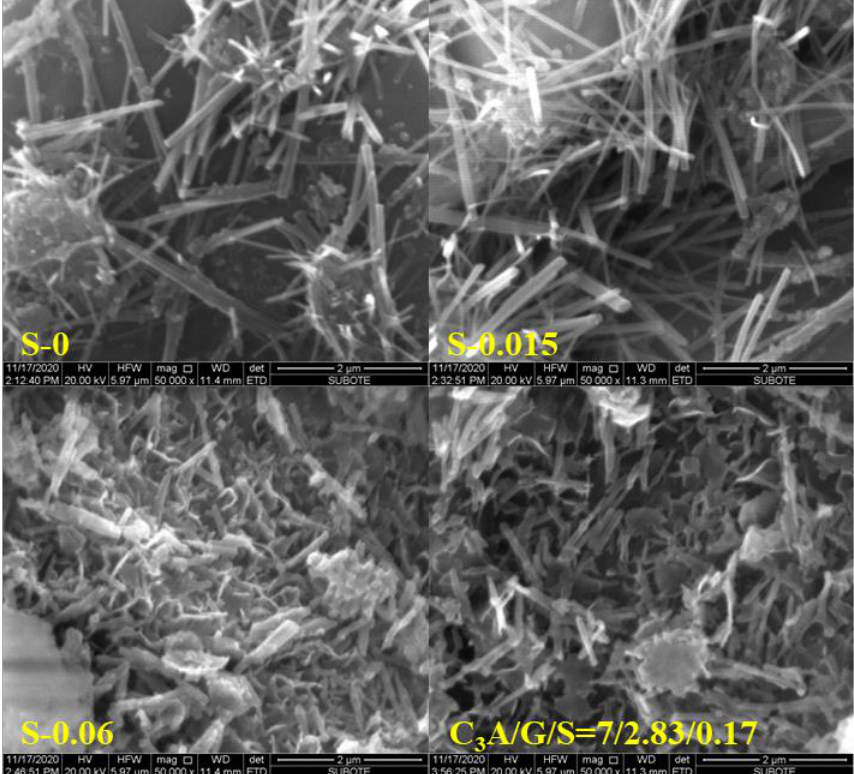
Figure 7. Effect of SO 4 2− concentration in simulated solution and Na 2 SO 4 in solid on morphology of precipitated ettringite.